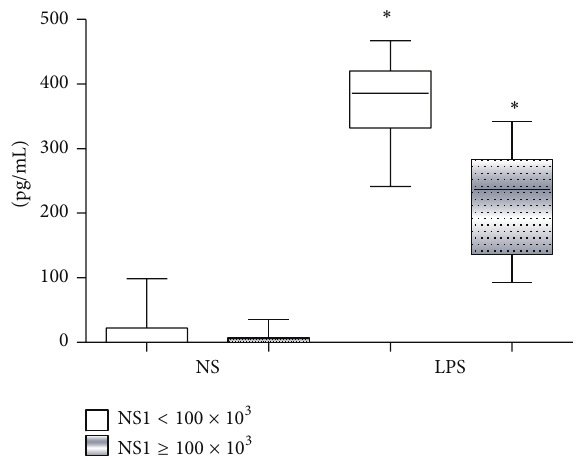
Figure5:Tumornecrosisfactoralpha(TNF- 𝛼 )production(pg/mL) by1 × 10 6 peripheralbloodmononuclearcells(PBMCs)fromdengue infected patients ( 𝑛 = 37 ) during the acute phase of the disease presenting low (NS1 < 100 × 10 3 BRU/mL) and high (NS1 ≥ 100 × 10 3 BRU/mL) NS1 serum levels. PBMCs were not stimulated (NS) or stimulated for 18 hours with 10 𝜇 g/mL of lipopolysaccharide (LPS) and TNF- 𝛼 production measured by ELISA. Results were expressed as median using a box plot. Equivalent symbols ( ∗ ) represent statistically significant differences ( 𝑃 < 0.05 ) between